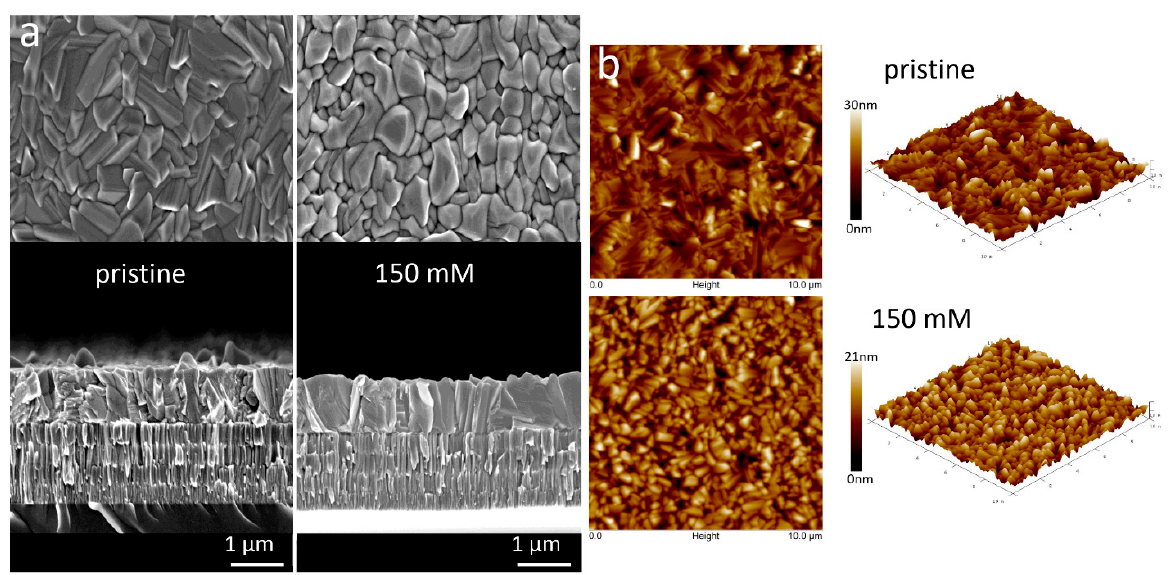
Figure 1. ( a ) SEM images, cross-sectional views and ( b ) AFM images of the pristine Sb 2 Se 3 film and those thermally treated in glycerol at 150 mM SbCl 3 for 90 min at 300 °C.